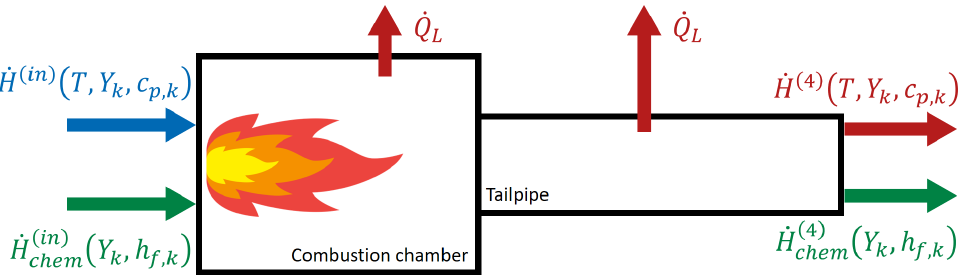
Figure 5. Scheme of the pulsation reactor energy